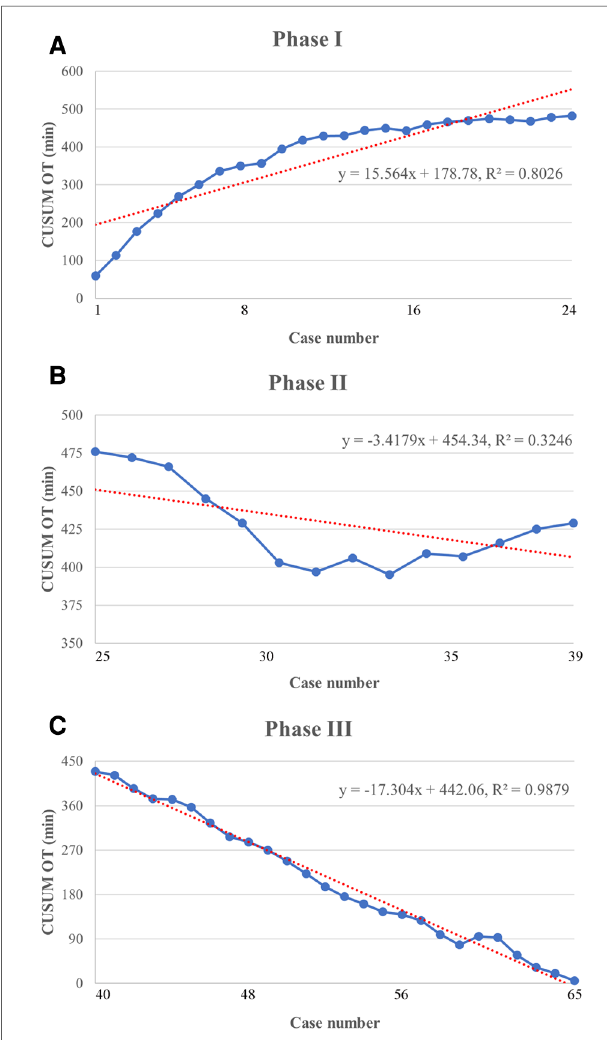
FIGURE 4 Lines of best fi t for each phase of the CUSUM OT learning curve. ( A ) Phase I of the CUSUM OT learning curve represents the initial training phase ( y = 15.564 x +178.78, R 2 =0.8026). ( B ) Phase II of the CUSUM OT learning curve represents the improvement phase ( y = − 3.4179 x +454.34, R 2 = 0.3246). ( C ) Phase III of the CUSUM OT learning curve represents the mastery phase ( y = − 17.304 x +442.06, R 2 =0.9879).